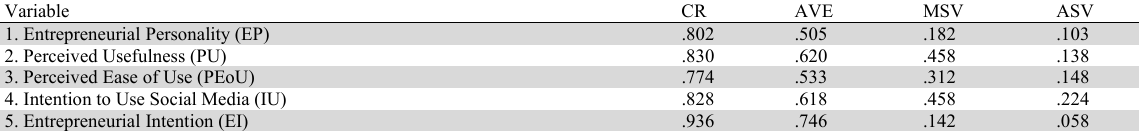
Composite reliability, convergent validity, and discriminative validity